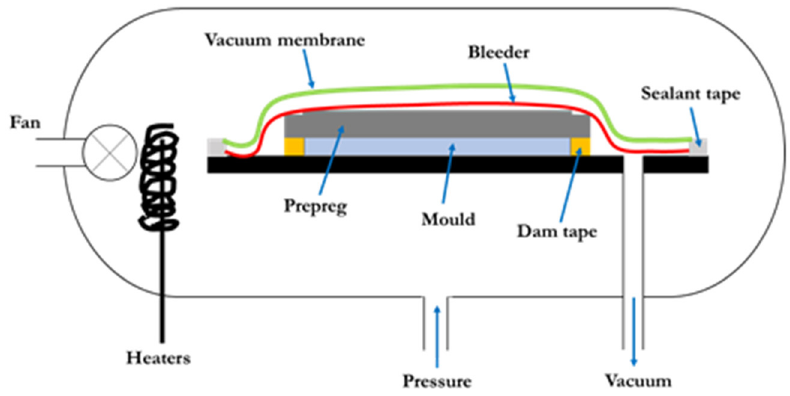
Figure 2. Fundamental components of an Autoclave process (redrawn from [20]).